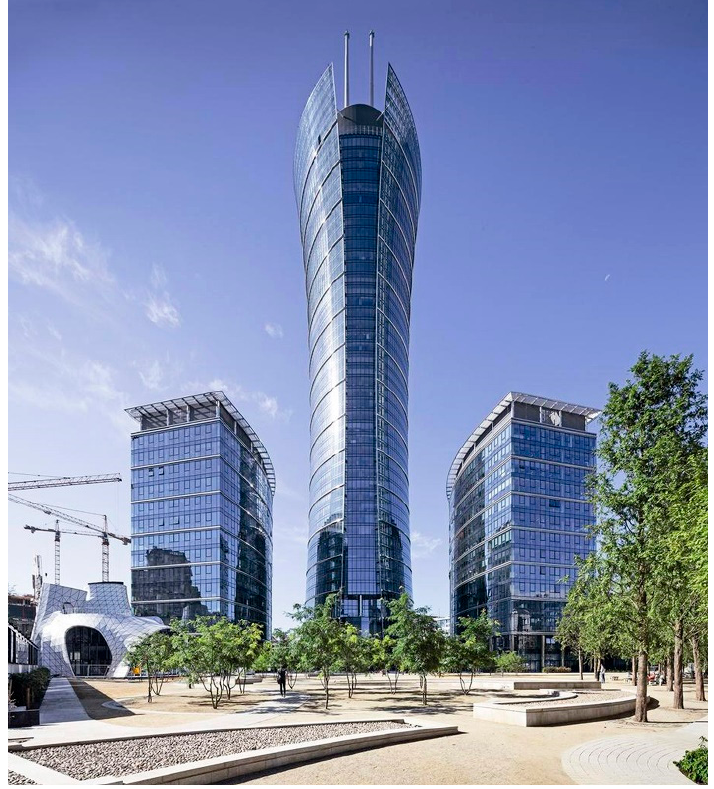
Figure 4. Warsaw Spire—view from Europejski Square. Source: author’s study.